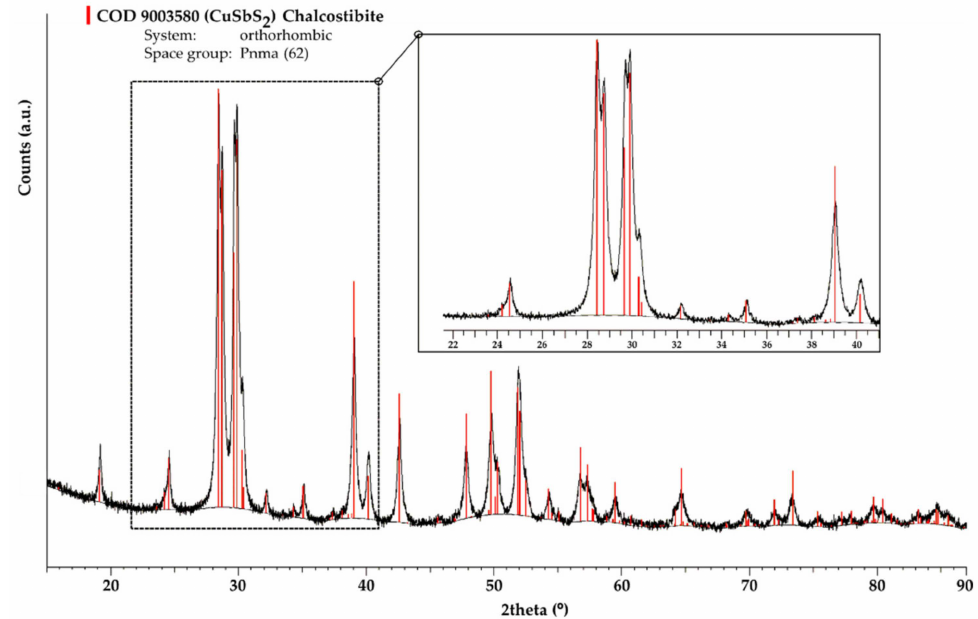
Figure 1. XRD pattern of CuSbS 2 powders produced directly by mechanochemical synthesis for 2 h (solid black line—observed XRD pattern, thin black line—background). Typical Rietveld analysis outputs for the 2 h MCS CuSbS 2 powders are presented in